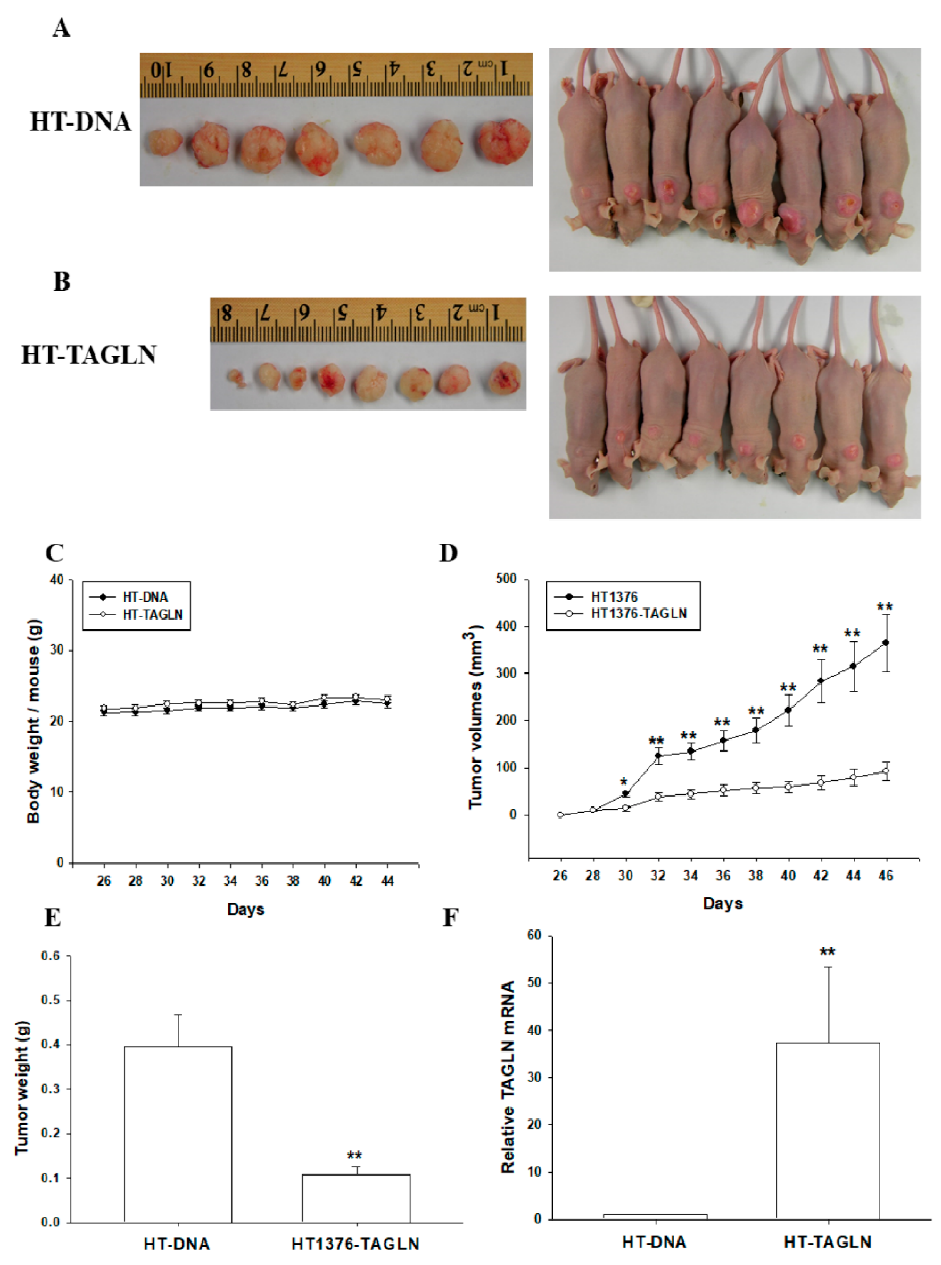
Figure 5. The ectopic overexpression of TAGLN attenuates tumorigenesis, in vivo, for bladder carcinoma HT1376 cells. Four-week-old male athymic nude (nu / nu) mice were randomized into